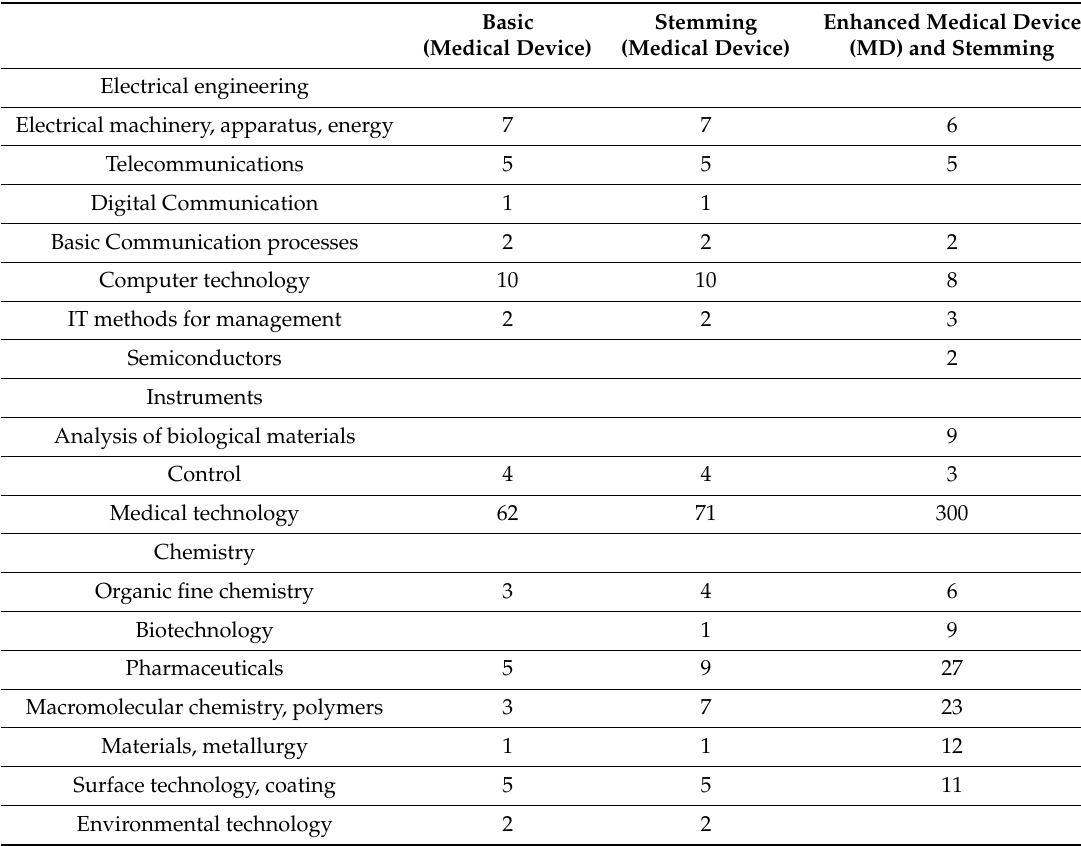
Table 1. Technological areas mentioned in patent applications.